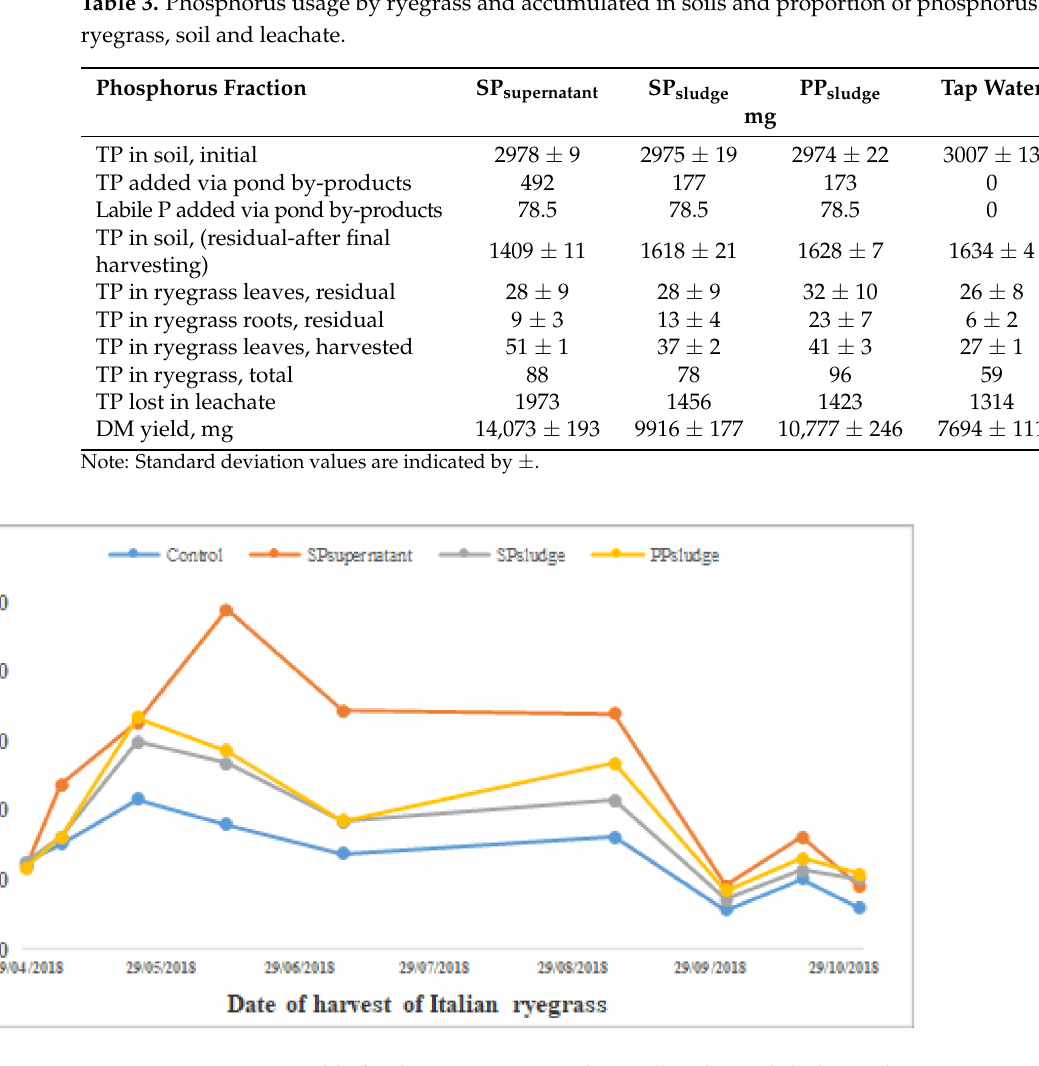
Figure 5. Dry matter yield of Italian ryegrass in soil treated with pond sludge and